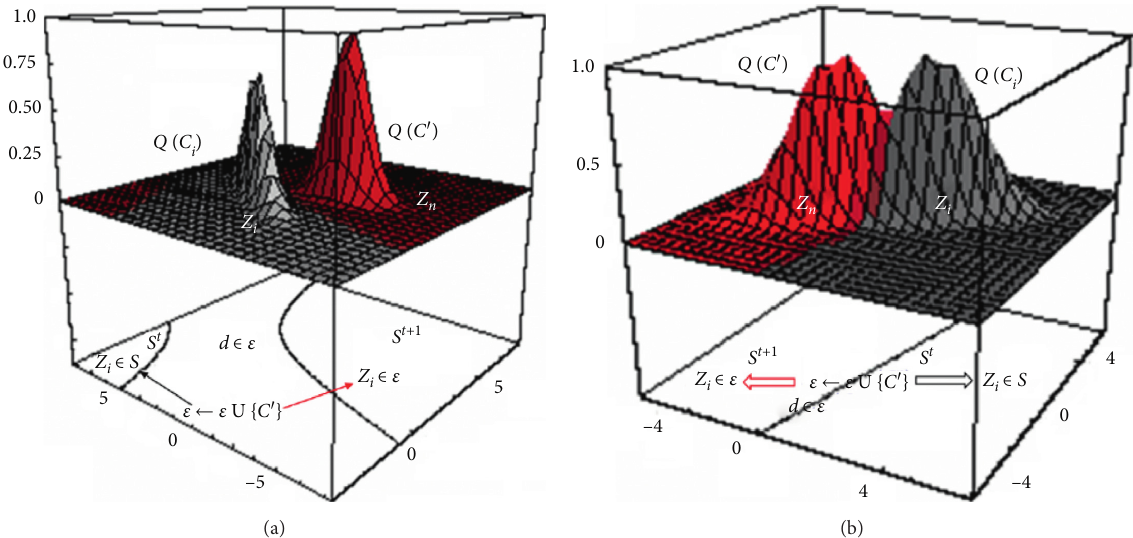
Figure 4: The process of instance dataset partitioning: (a) preliminary partitioning of candidate classifier C ′ ; (b) weighting and updating of classifier C i